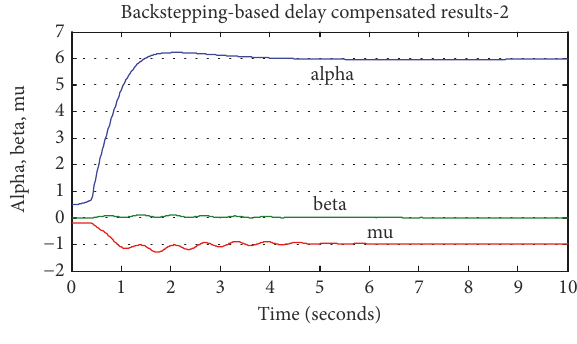
Figure 7: Compensated tracking results in extreme.